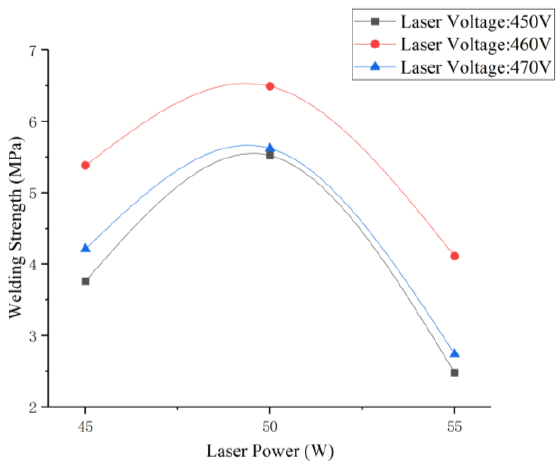
Figure 3. Effect of laser surface treatment power on welding strength.